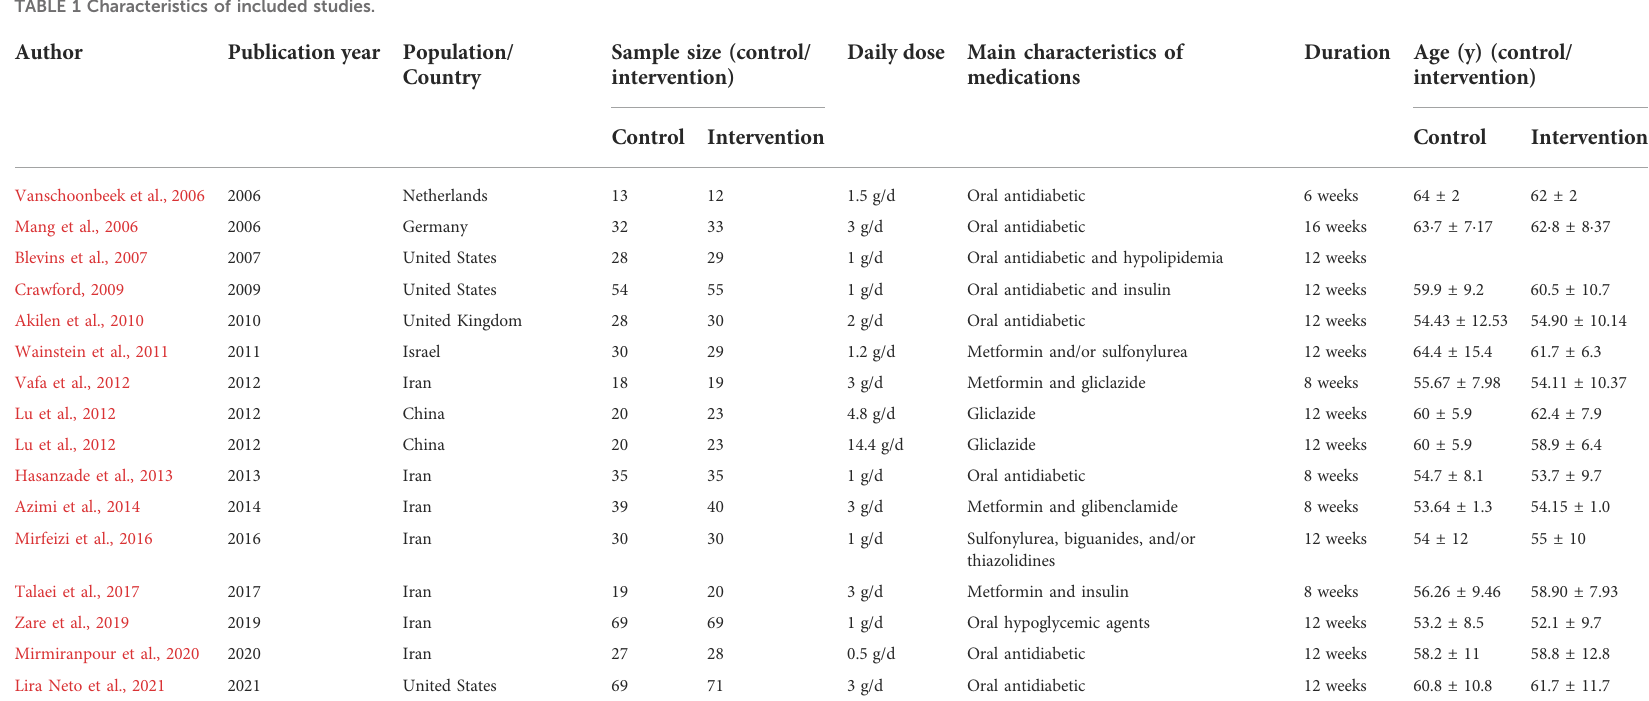
TABLE 1 Characteristics of included